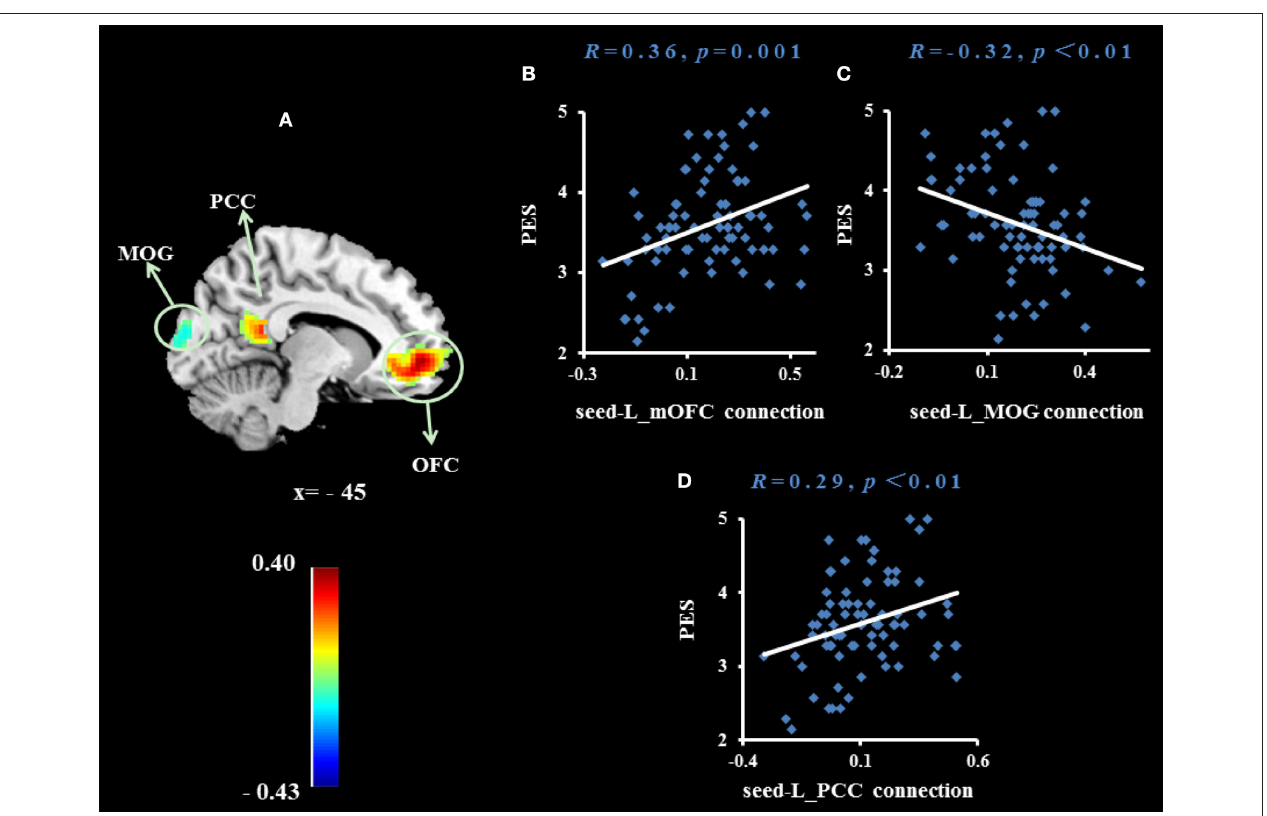
FIGURE 3 | Brain region whose functional connectivity strength with the right dorsomedial prefrontal cortex (seed) was significantly associated with the average score of PES (A) . The threshold of corrected cluster was set at P < 0.05 [single voxel P < 0.001, cluster size > 137 voxels, and 1000 iterations]. Color bars represent R-values. L = left, R = right. (B–D) indicate significant correlations between PES and functional connectivity strengths between the left medial orbitofrontal cortex (mOFC), left middle occipital gyrus (MOG) and left posterior cingulate cortex